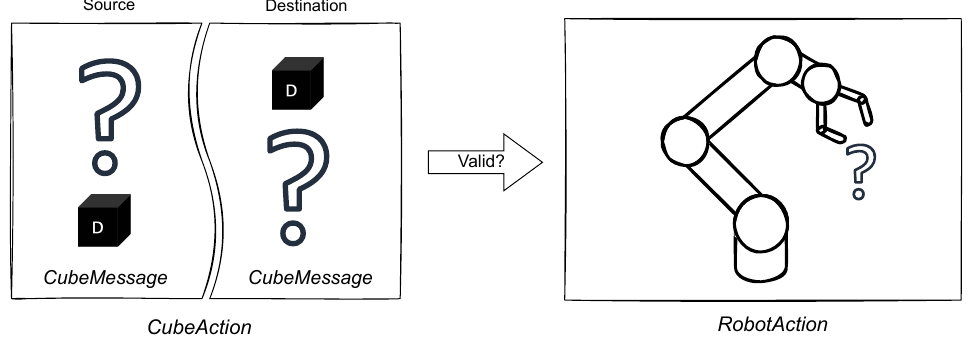
Figure 8. Conversion of CubeAction to RobotAction .